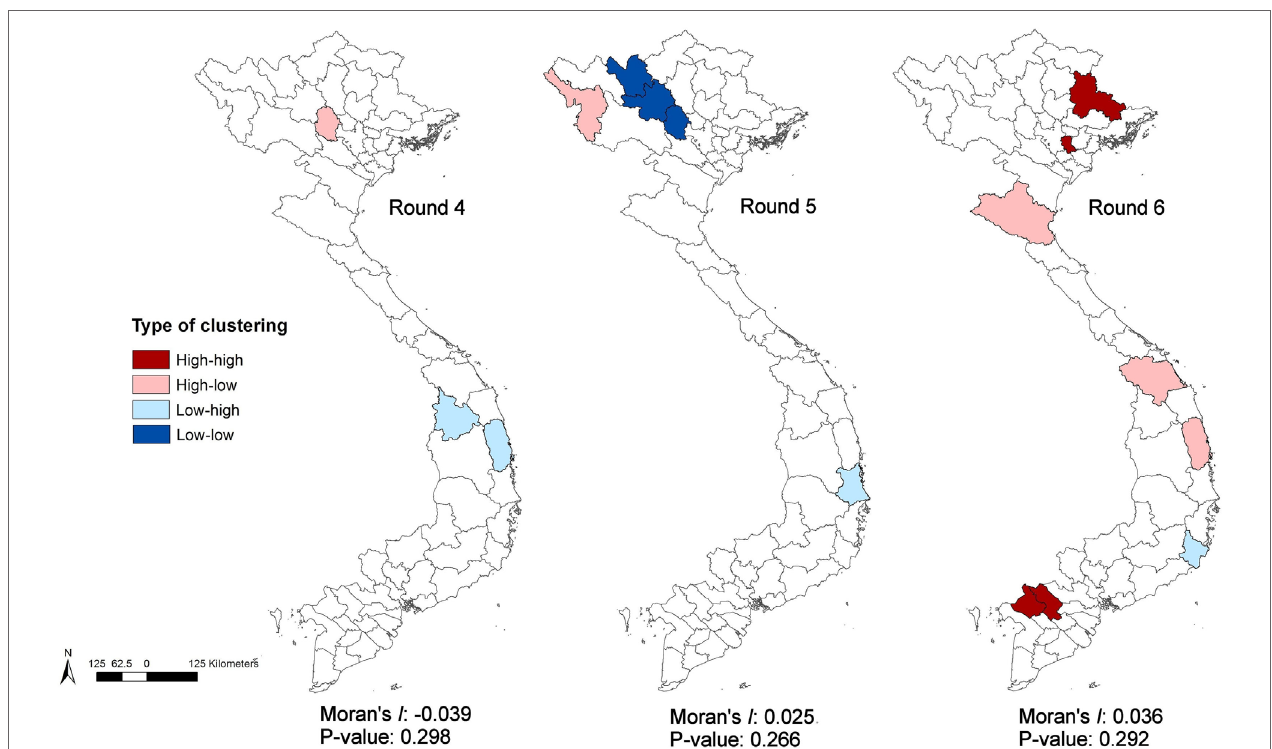
FigUre 5 | Local Indicators of Spatial Association cluster maps and Moran’s I statistics of empirical Bayes risk estimates of highly pathogenic avian influenza H5N6 for Rounds 4–6.